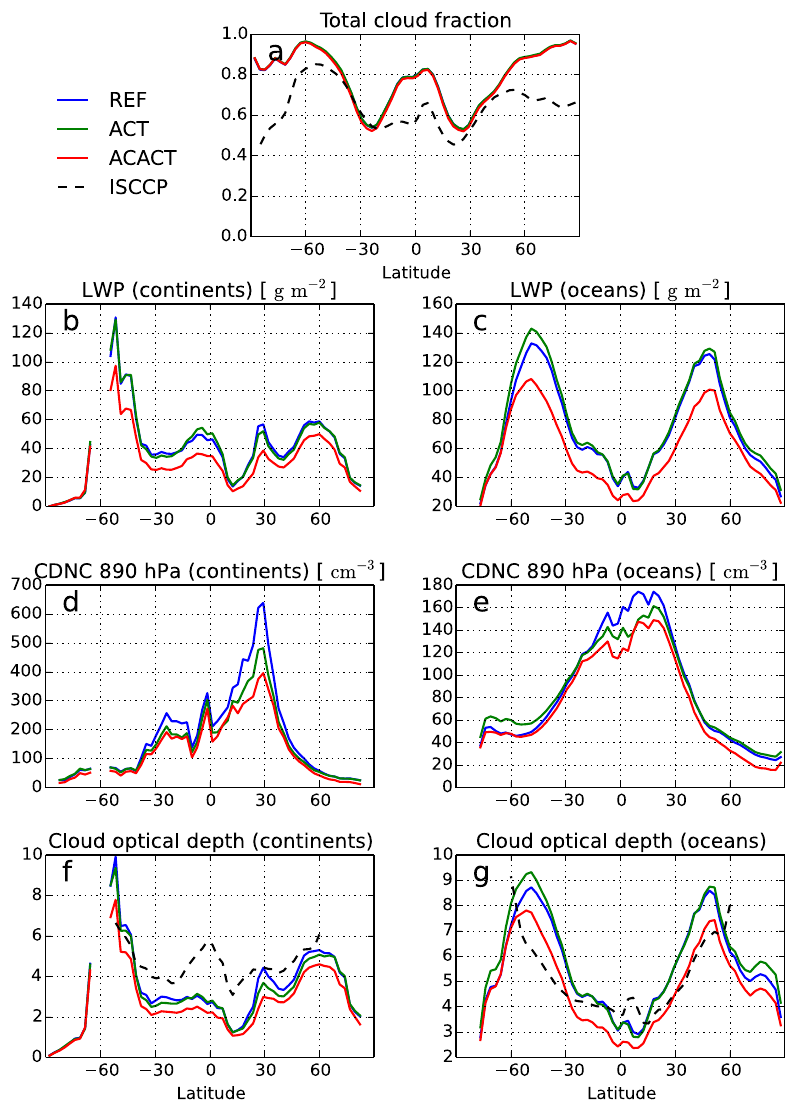
Figure 1. Zonal mean cloud properties for present-day conditions for different model configurations (summarized in Table 1) and observa- tions from ISCCP. (a) Vertically integrated total cloud fraction, (b) liquid water path (LWP) sampled over continents, (c) LWP over oceans, (d) CDNC sampled over continents at the 890hPa level, (e) CDNC over oceans, (f) cloud optical depth ( τ ) over continents and (g) τ over oceans. Note that the ISCCP simulator was used to obtain the model estimates for (a) , (f) and (g) .